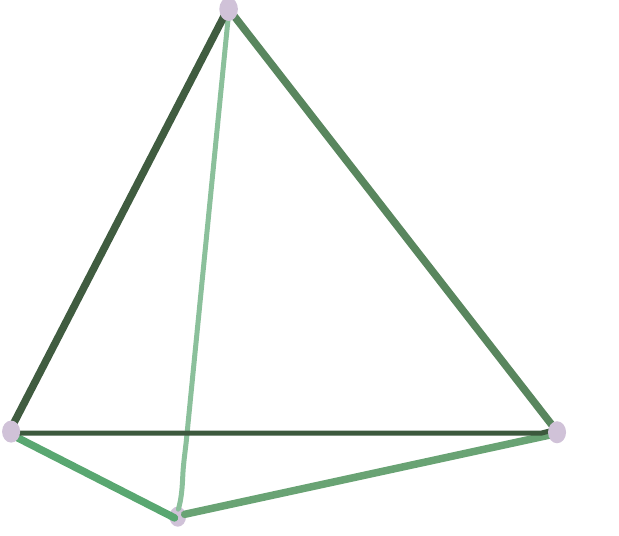
Figure 1: The regular tetrahedron.